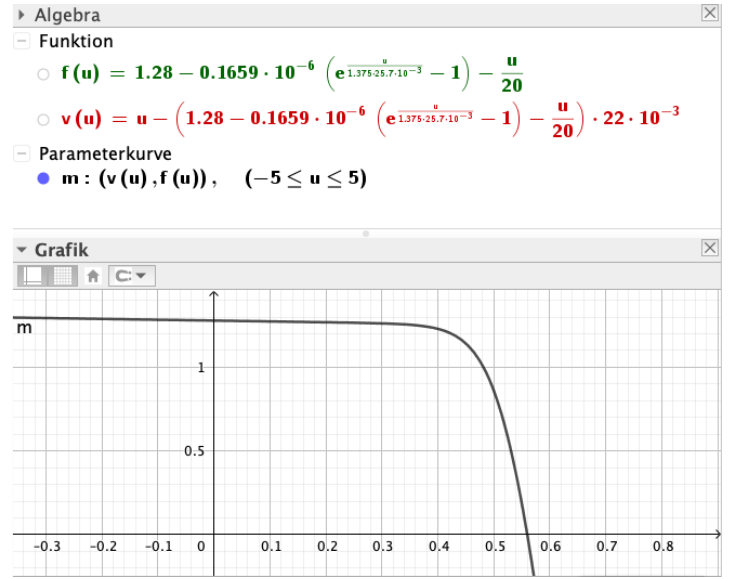
Figure 2. Curve C IV is situated in the first